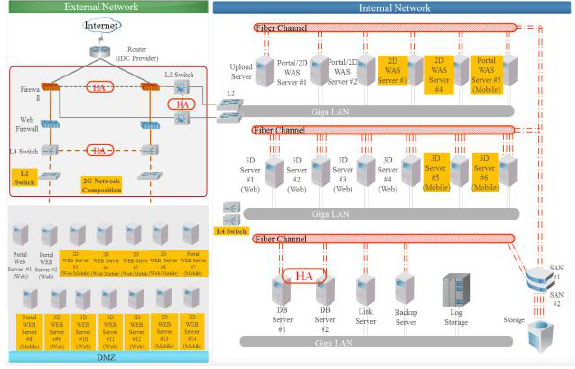
Figure 6. A Composition Map of Open Platform